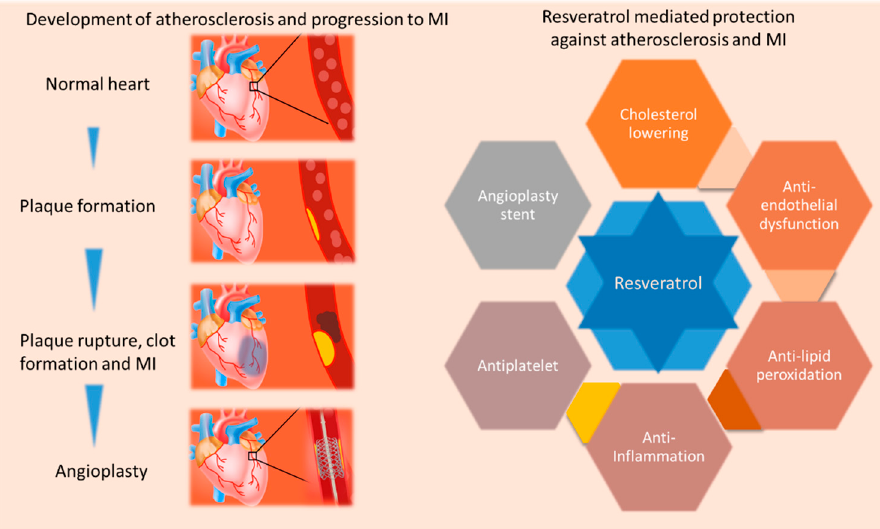
Figure 2. Schematic depicting resveratrol mediated reduction in ischemic heart disease by targeting various factors. Atherosclerosis develops due to lipid accumulation and inflammation in arteries leading to the plaque formation, plaque rupture, thrombus formation and MI. Resveratrol decreases the level of bad cholesterol, lipid peroxidation, inflammation and platelet aggregation and improves endothelial function and re-endothelialization (when use in drug-eluting stents), suggesting manifold action of resveratrol in improving ischemic heart disease.